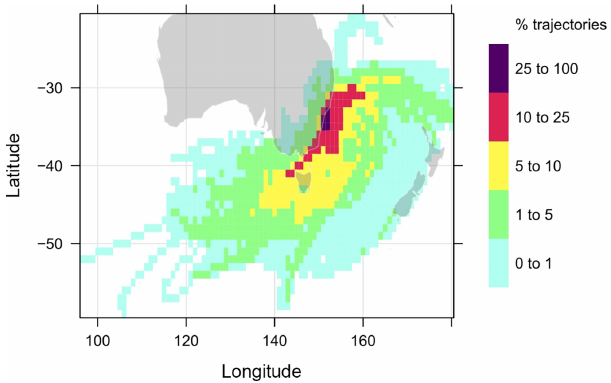
Figure 4. The 96-hour gridded back trajectory frequencies during MUMBA. The surface is coloured by the percentage of total trajec- tories which pass through each grid